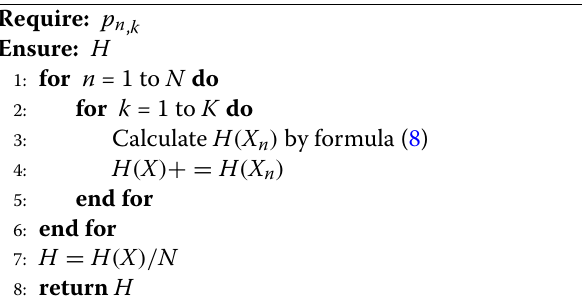
Algorithm 2 The Average Privacy Entropy for Offloading Tasks